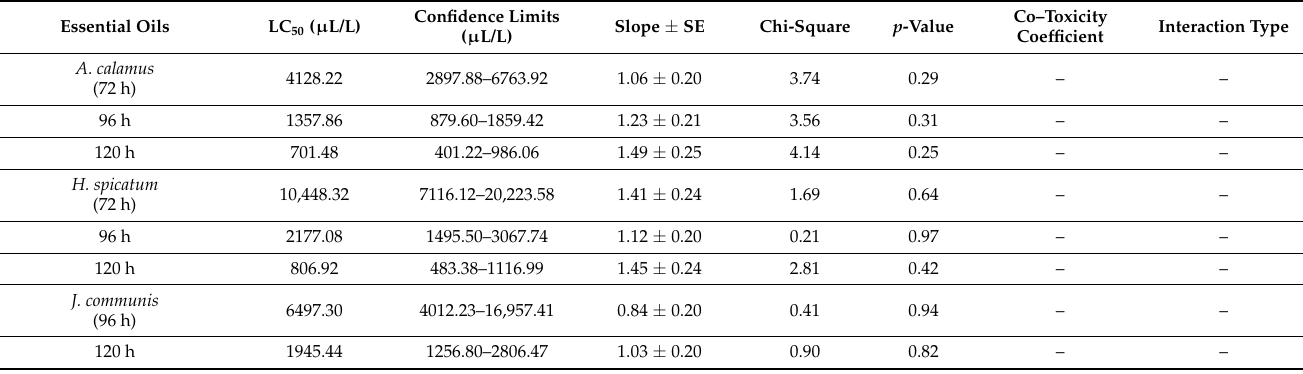
Table 2. Toxicity of different essential oils and their combinations against C. maculatus